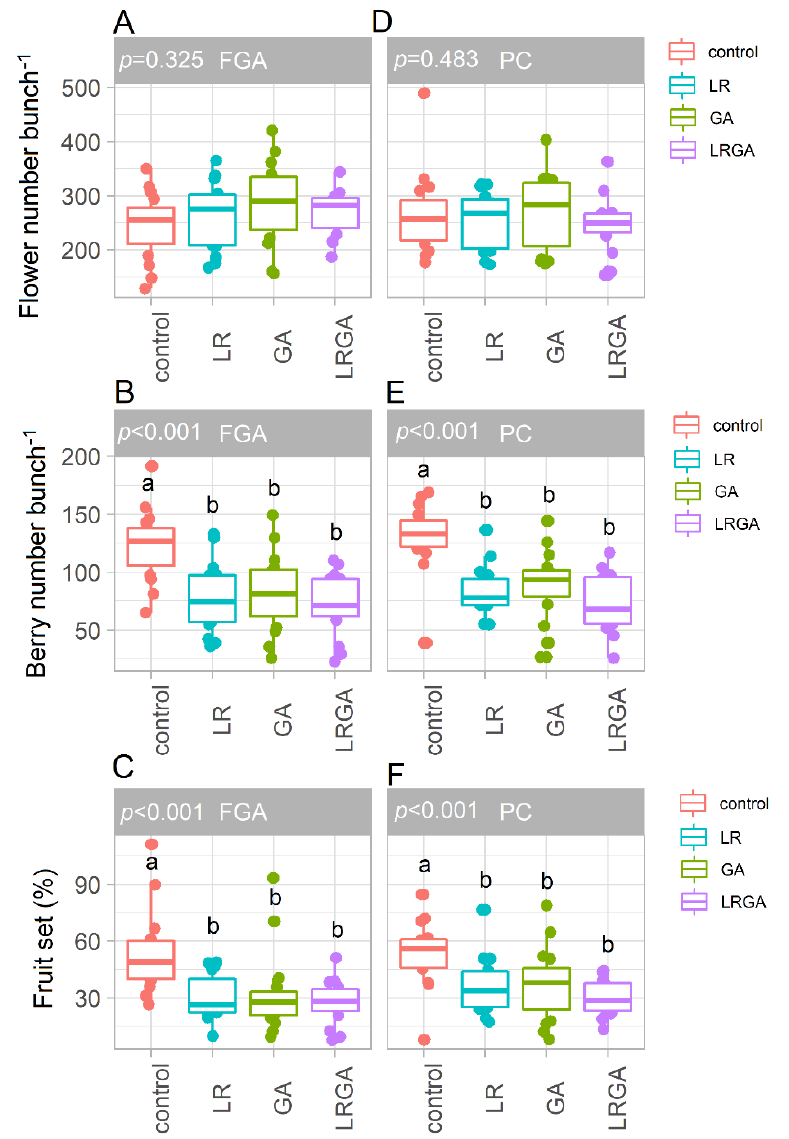
Figure 2. Number of flowers per bunch ( A , D ) number of berry per bunch ( B , E ) and fruit set %( C , F ) assessed either in FGA and PC vineyard and in control, leaf removal (LR), GA 3 application (GA) and leaf removal plus GA 3 application (LRGA) plants (n = 15). In graphs, points represent raw data, horizontal lines within boxes indicate the median and boxes indicate the upper (75%) and lower (25%) quartiles. Whiskers indicate the ranges of the minimum and maximum values. Data were analyzed with one-way ANOVA with treatments as factor and p -value is shown in the graph. Different letters represent significant differences between treatments according to Tukey ’ s test.